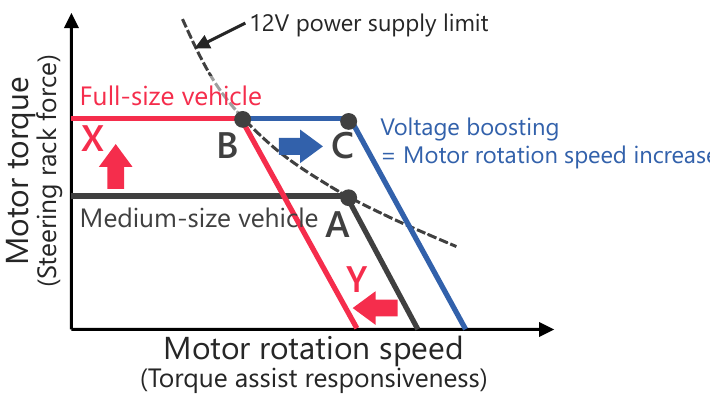
Figure 7. Motor rotation speed and torque characteristic diagram (N–T characteristic diagram of brushless DC motor).